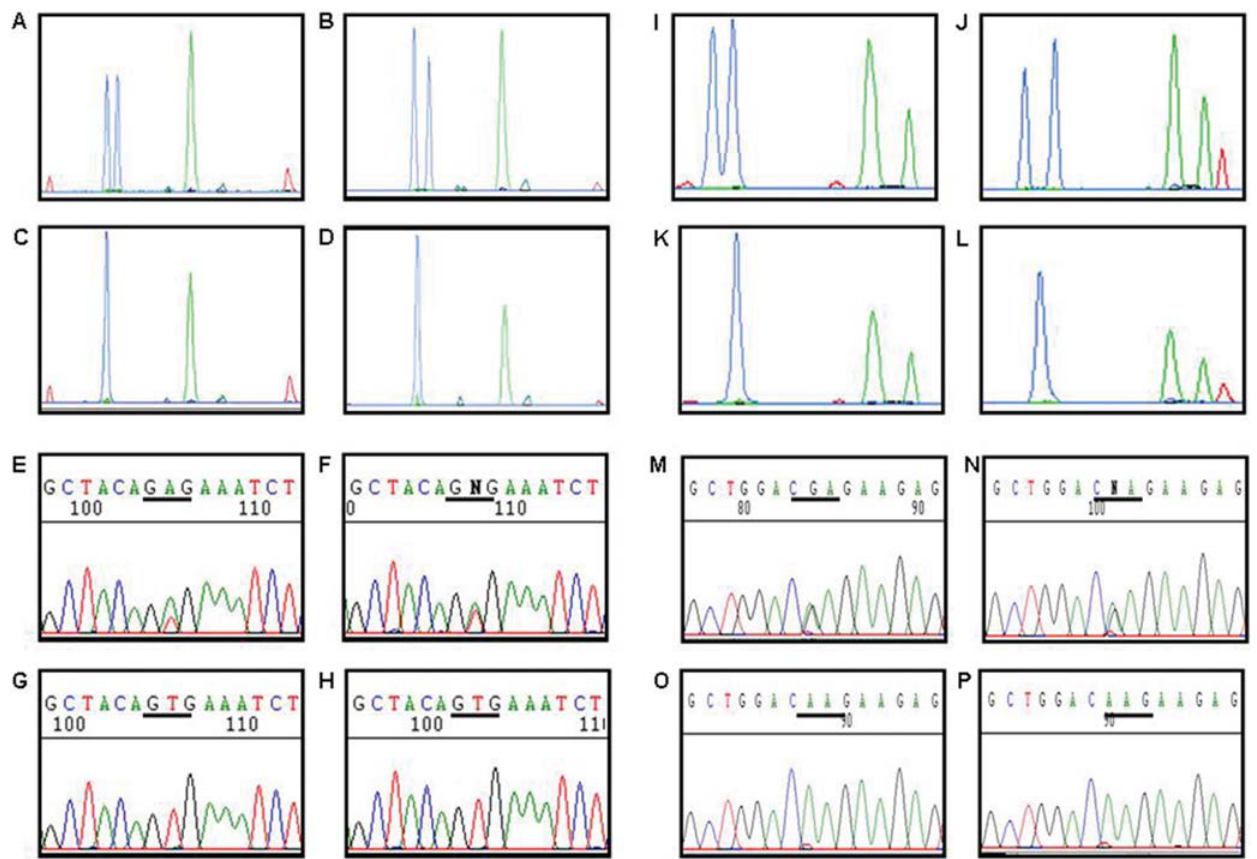
Figure 2. Detection and identification of B-RAF and N-RAS mutations in melanoma cell lines and corresponding tissues by fluorescent capillary electrophoresis SSCP and DNA sequencing. Migration patterns under non-denaturing conditions of single stranded fragments of exon 15 of the B- RAF gene with a T1799A mutation at codon 600 in the cell line Ma-Mel-36 (A) and the corresponding tumor tissue (B). Migration patterns for the B- RAF exon 15 fragments with wild type sequences in the cell line Ma-Mel-37a (C) and the corresponding tumor tissue (D). Panels (E) to (H) show sequence analyses of the cell lines and tumor tissues given in (A) to (D). Fluorescent capillary electrophoresis patterns for the N-RAS exon 2 sequence with a CAA . CGA mutation at codon 61 in the cell line Ma-Mel-05 (I) and the corresponding tumor tissue (J). Migration patterns for the N-RAS exon 2 fragments with wild-type sequences in the cell line Ma-Mel-59 (K) and the corresponding tumor tissue (L). Panels (M) to (P) show the confirmation of the mutations in the cell lines and tissues shown in (I) to (L) by sequence